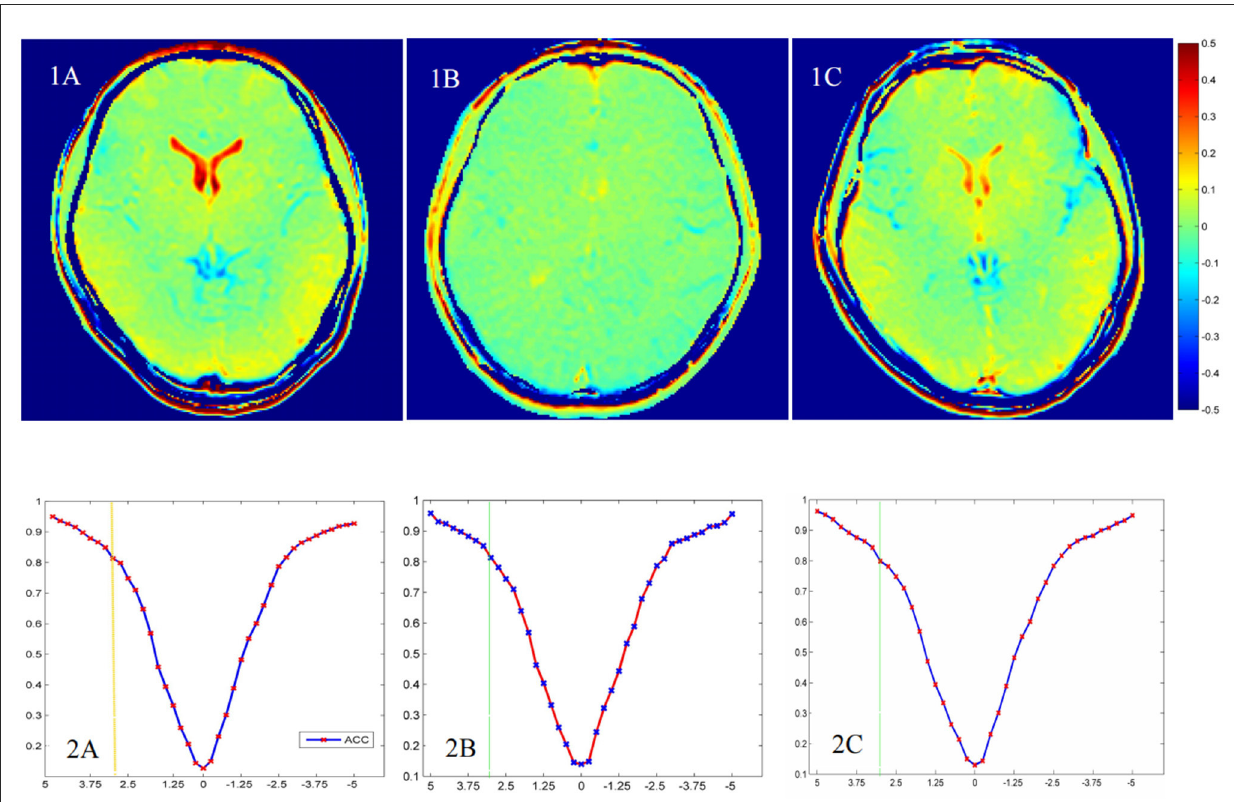
FIGURE4 The chemical exchange saturation transfer (CEST) for glutamate (GluCEST) maps (1A–C) and z-spectra in the anterior cingulate cortex (ACC) (2A–C) of different groups. The healthy control group (1A, 2A) , the unipolar depression group (1B, 2B) , and the bipolar disorder group (1C, 2C) .